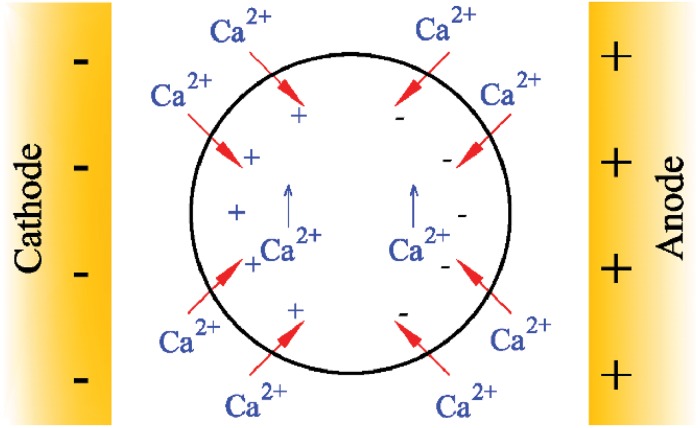
Response of a cell to a dcEFs.A simple cell in the resting state has a negative membrane potential [25]. When a cell with a negligible voltage-gated conductance is exposed to a dcEF, it is hyperpolarised membrane near the anode attracts Ca2+ due to passive electrochemical diffusion. Consequently, this side of the cell contracts, propelling the cell towards the cathode. Therefore, voltage-gated Ca2+ channels (VGCCs) near cathode (depolarised side) open and a Ca2+ influx occurs. In such a cell, intracellular Ca2+ level rises in both sides. The direction of cell movement, then, depends on the difference of the opposing magnetic contractile forces, which are exerted by cathode and anode [25].